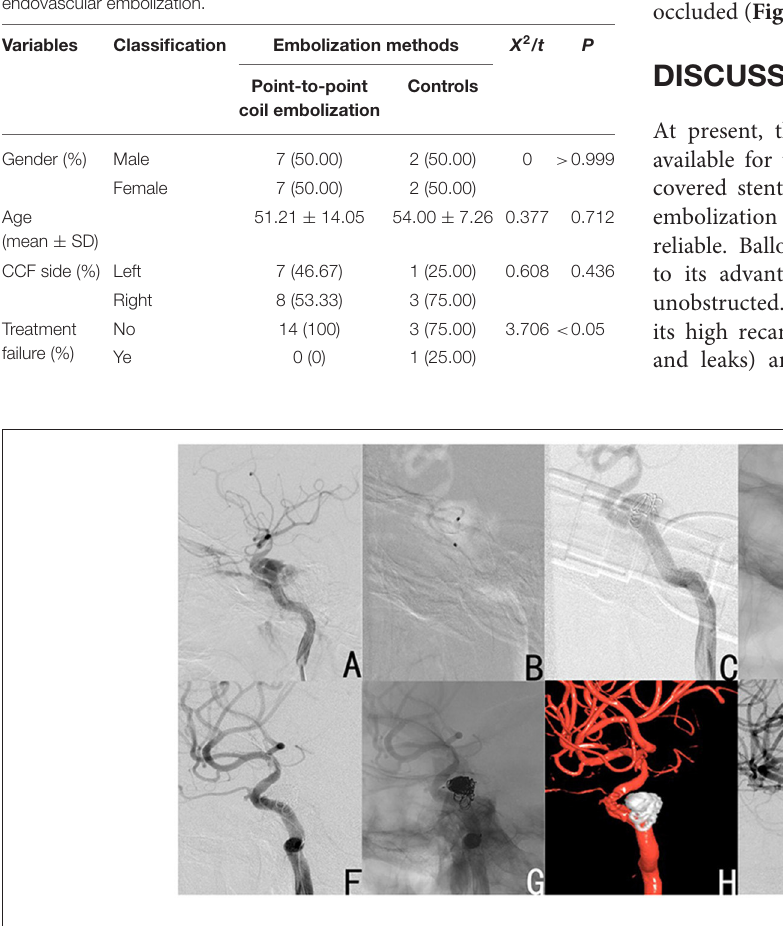
FIGURE 3 | Case 7 had a right CCF ( A : lateral view). After the location of the fistula was determined, the deep microcatheter was put in place (B) , and a large coil was used to form a basket as a support (C,D) . Then, the other coils were filled into the shallow part of the fistula by the shallow microcatheter (E) , until the fistula disappeared (F) . The angiography without subtraction (G) and 5s-3D angiography (H) revealed that these coils were stable and tightly covered the fistula, dense in the shallowness of the fistula, and loose in the depth of the fistula. At 18 months after the operation, the DSA revealed no recanalization of the fistula, excellent reconstruction of the parent vessel (I) , and the stable shape of these coils (J)